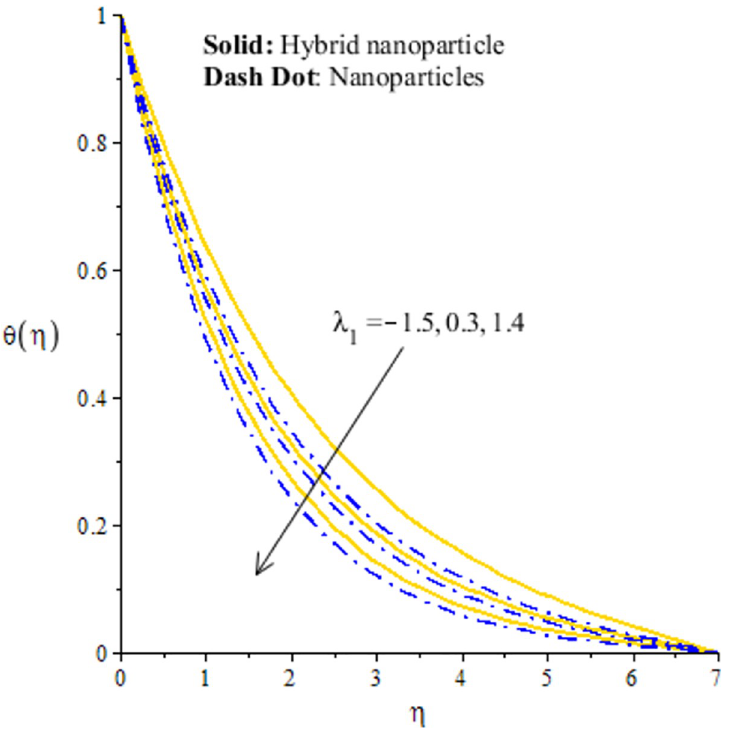
Fig 8. Distribution of temperature versus λ 1 .